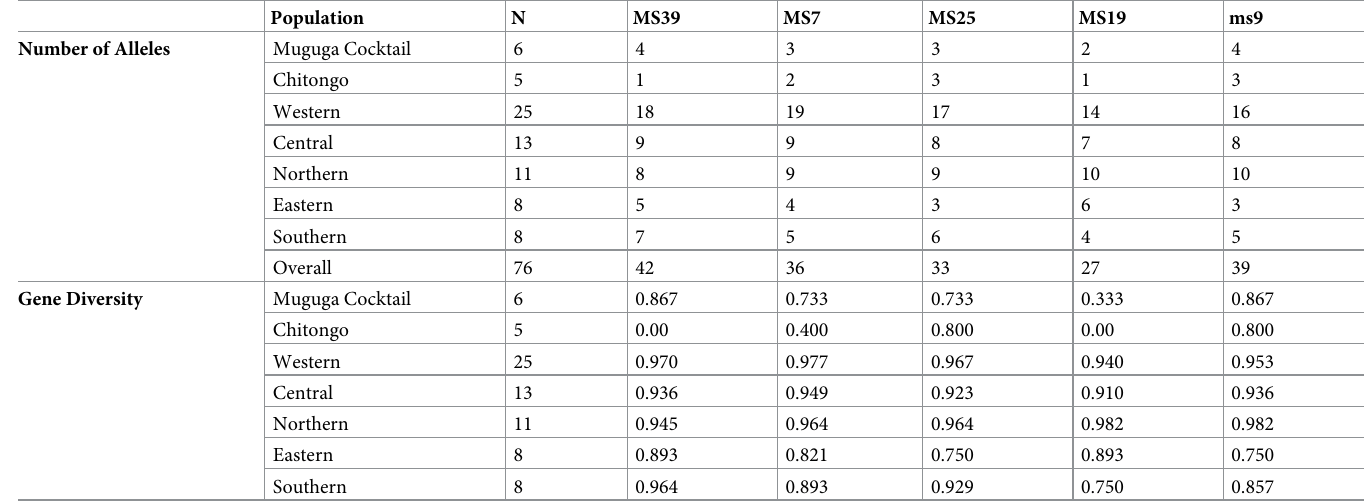
Table 5. Genetic diversity and number of alleles of Theileria parva from, Burundi field samples, Muguga cocktail and Chitongo vaccine stocks.